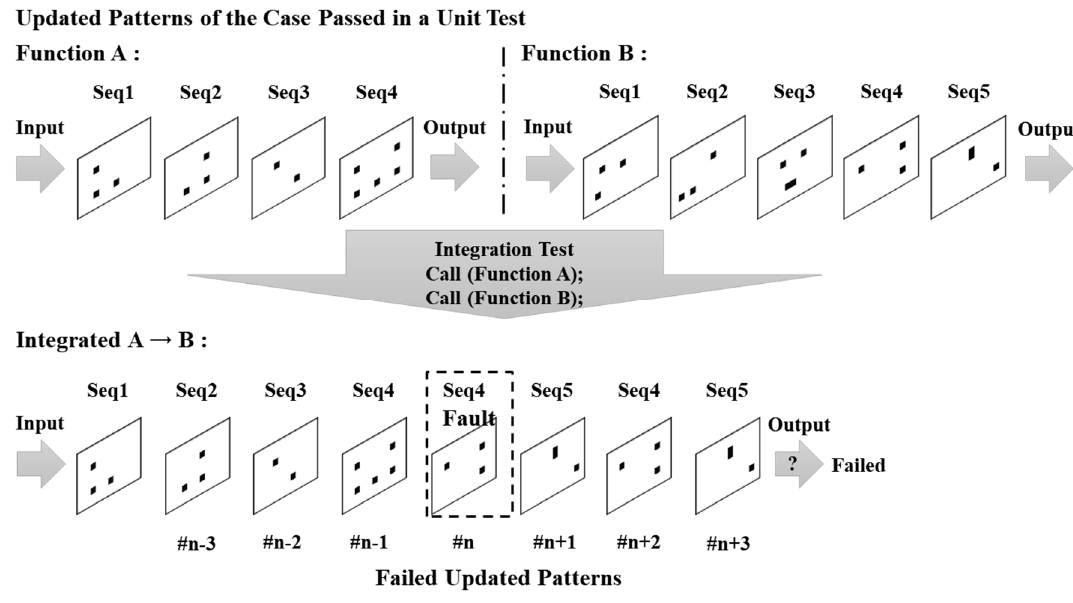
Figure 1. Example of fault localization of using memory-updated patterns in an integration test.